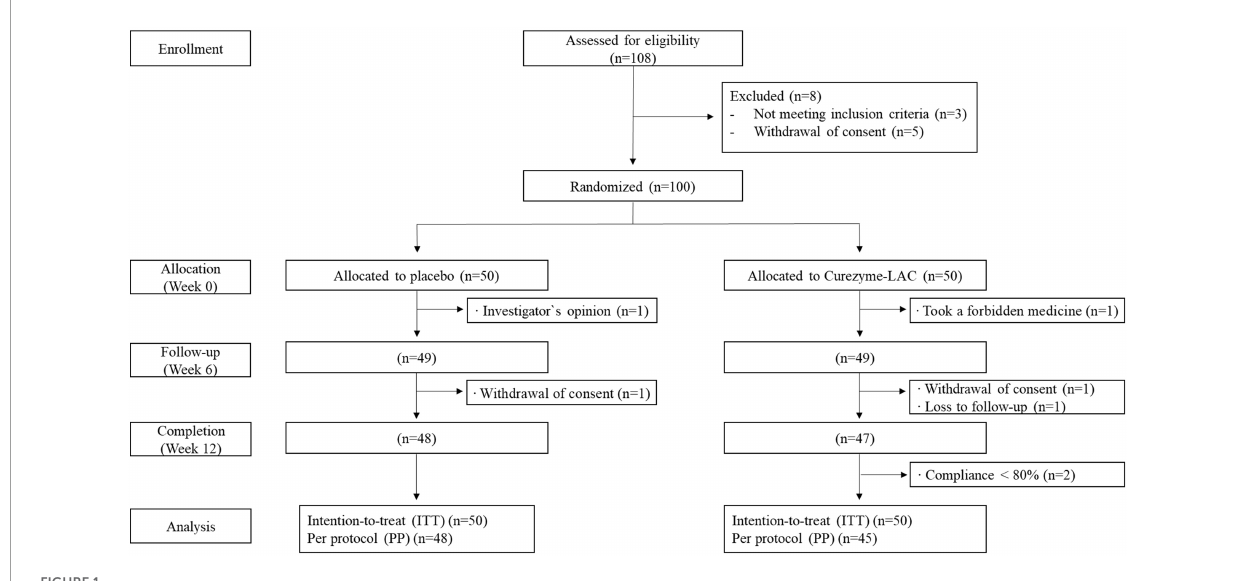
FIGURE1 CONSORT diagram for flow of subjects through the study.